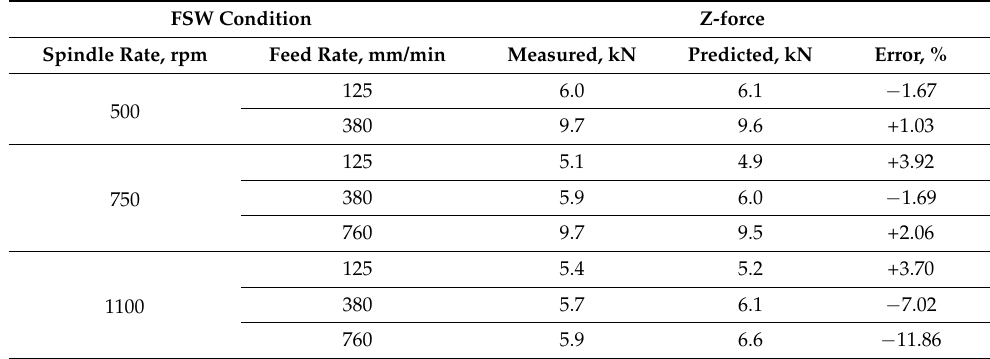
Table 3. Comparison of predicted Z-force with experimental